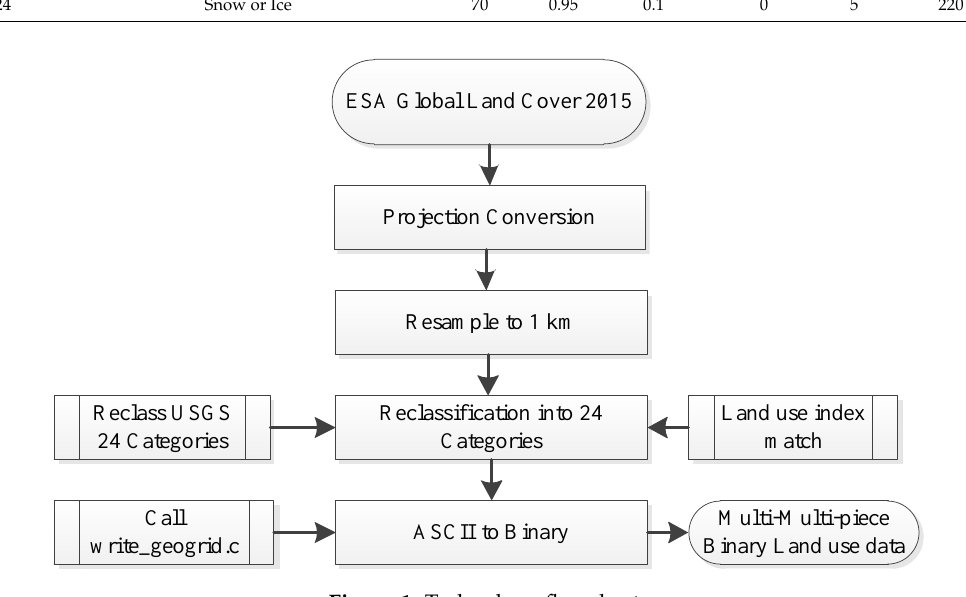
Figure 1. Technology flowchart.